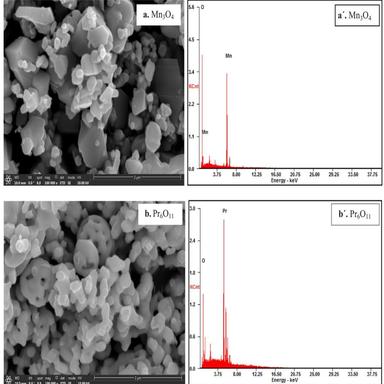
FE-SEM images of Mn3O4 (a), Pr6O11 (b) and EDX spectrum of Mn3O4 (a´), Pr6O11 (b´).